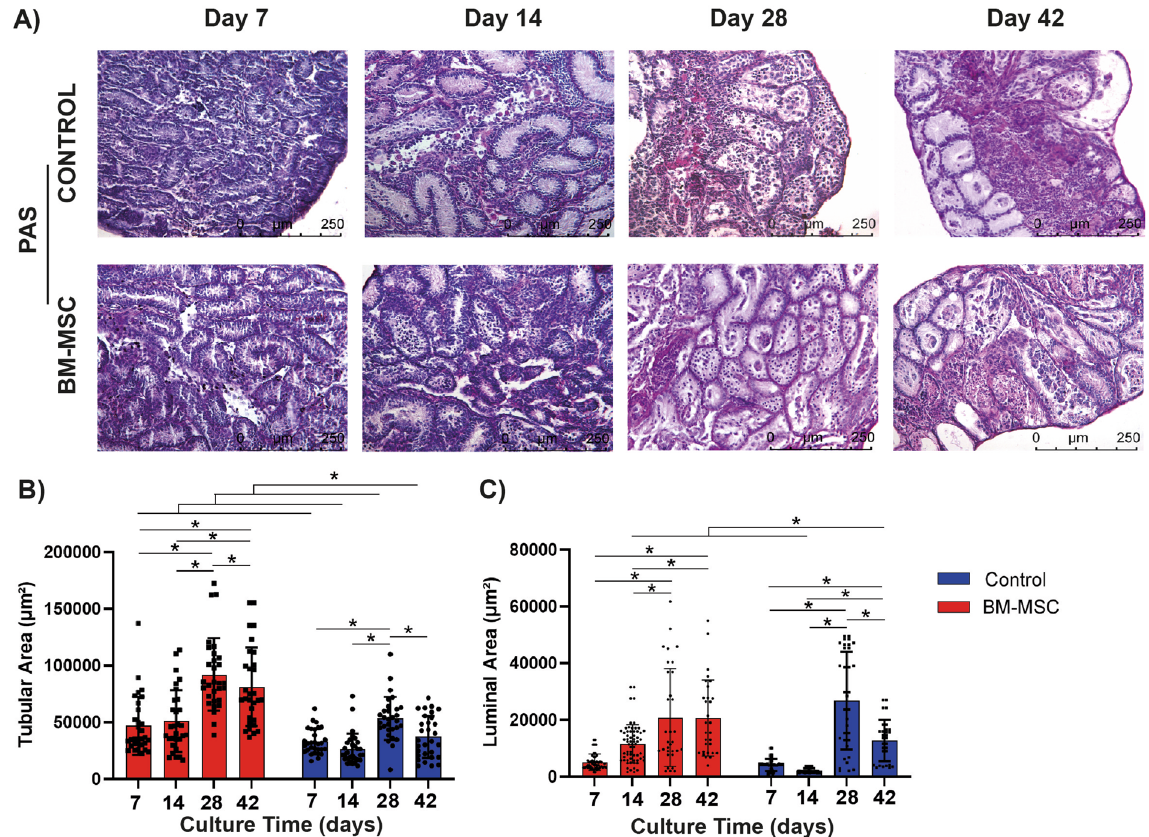
Figure 5. BM-MSCs promote testicular maturation in vitro. Micrographs presenting cultured mouse testes in ( A ) BM-MSC and control groups on days 7, 14, 28 and 42 (PAS-Hematoxylin, 100x). Bar graphs illustrate time dependent change by standard deviation and data distribution of ( B ) tubular and ( C ) luminal area (* p < 0.05, n = 6 testes, 300